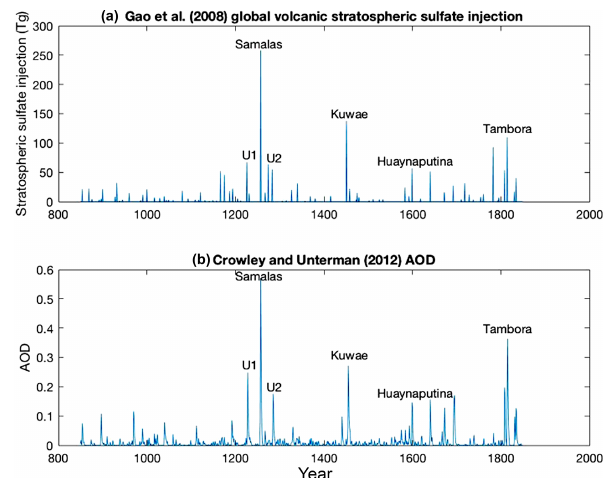
Figure 2. Time series of volcanic forcing from Gao et al. (2008) (a) and Crowley and Unterman (2012) (b) . The specific subset of volcanic eruptions investigated is